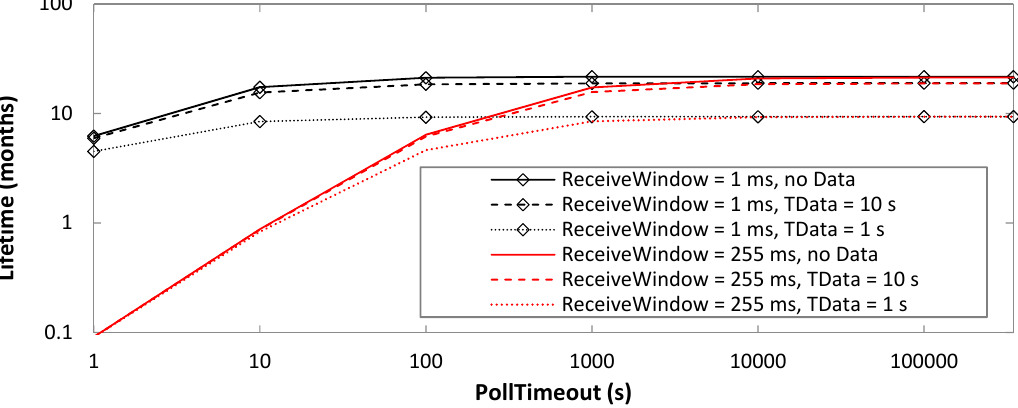
Figure 11. Impact of T Data on the BM-LPN lifetime, as a function of PollTimeout, for ReceiveWindow values of 1 ms and 255 ms, and as a function of PollTimeout.